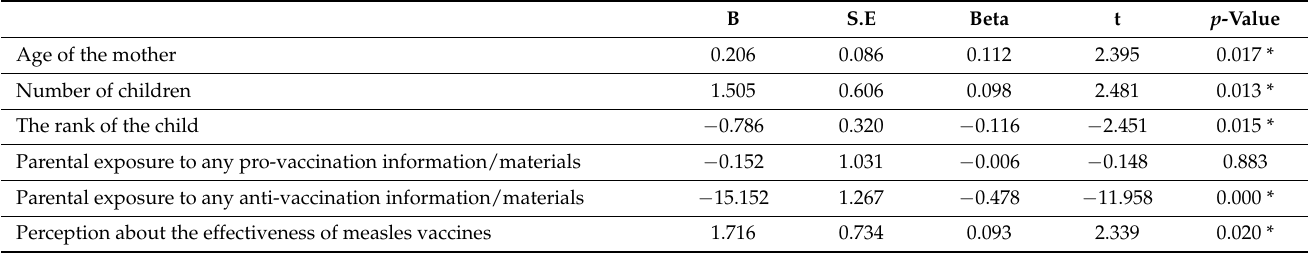
Table 3. Result of the multivariate regression model for estimates of associations of parental measles vaccine hesitancy with potential predictors (N =